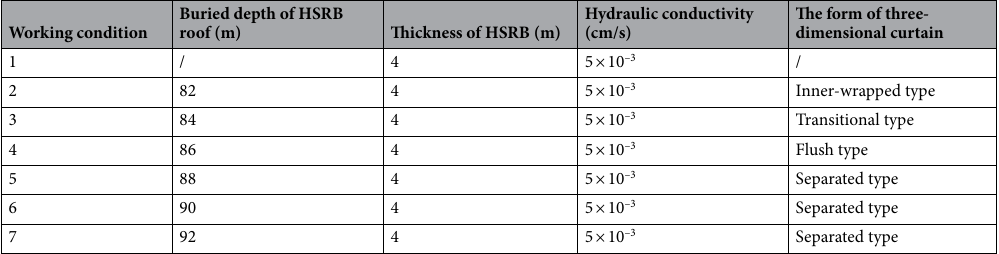
Table 4. Combination forms of three dimensional curtain.